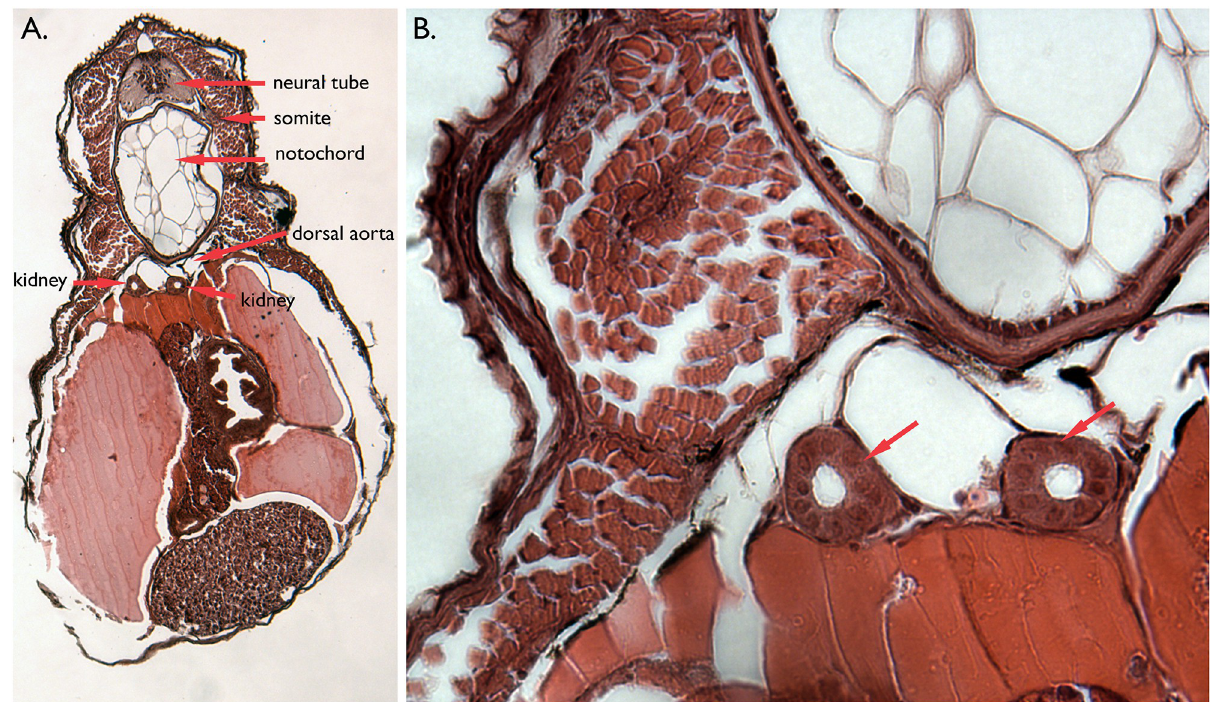
Fig 3. Internal anatomy of mid-hatching stage bay pipefish. A. Transverse section of a JB4 plastic embedded specimen. Various dorsal tissues surrounding the kidney tubules are labelled. B. Enlargement of panel A. The red arrows indicate the kidney